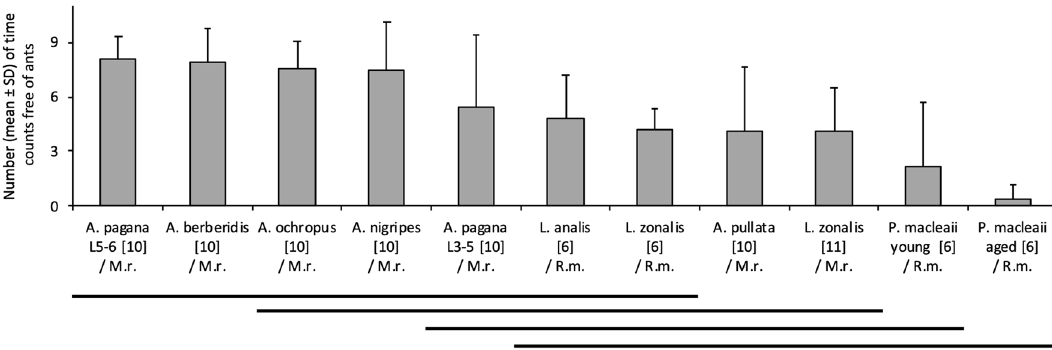
Figure 2. Defense effectiveness of sawfly larvae/instars against ants in short-term interactions. The histogram represents the numbers of time counts with no ant contacting a larva; the values are given as mean and standard deviation. Sawfly species/instars are given on the X -axis (Table 1). They are ordered from left to right by decreasing time-counts free of ants. The number of tested larvae is given between square brackets. The ant species used are Myrmica rubra (M.r.) and Rhytidoponera metallica (R.m.). Pairs of means grouped by a horizontal line are not significantly different from each other (Tukey–Kramer method, P > 0.05).